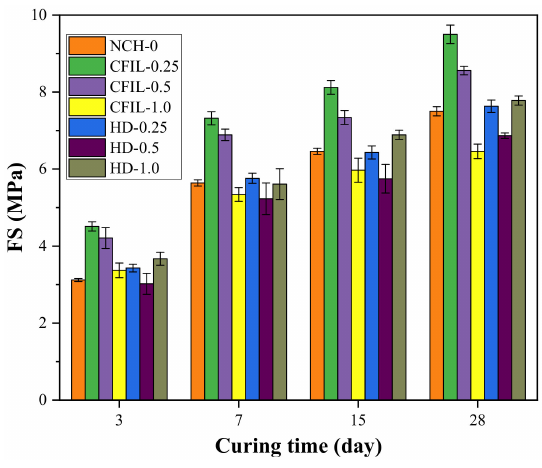
Figure 11. Relationship between FS and curing time.